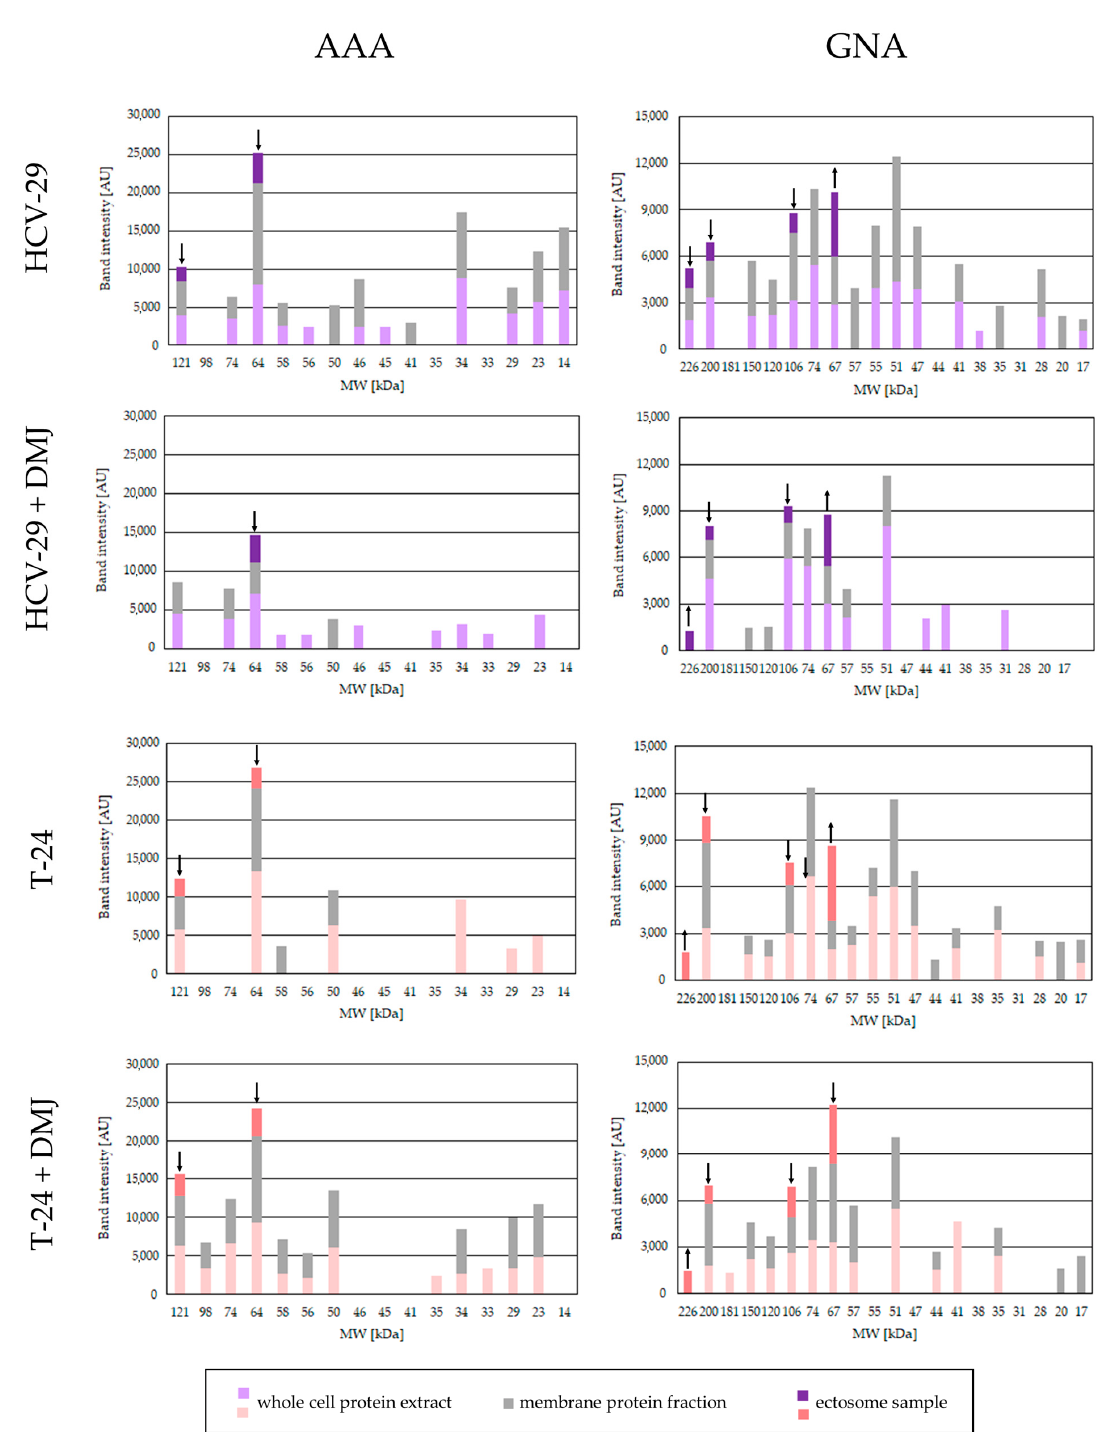
Figure 8. Densitometric analysis of AAA- and GNA-positive bands. The intensity of detected bands was expressed in arbitrary units (AU) as a peak area on respective densitogram. Each bar represents the intensity of corresponding bands in the whole cell protein extracts, membrane fractions and ectosome samples from each cell line. ↑ and ↓ denote a significant enrichment or depletion, respectively, of a given glycoepitope in the ectosomal fraction compared to membrane fraction. The values from control lectin blots with blocking solutions were subtracted beforehand.